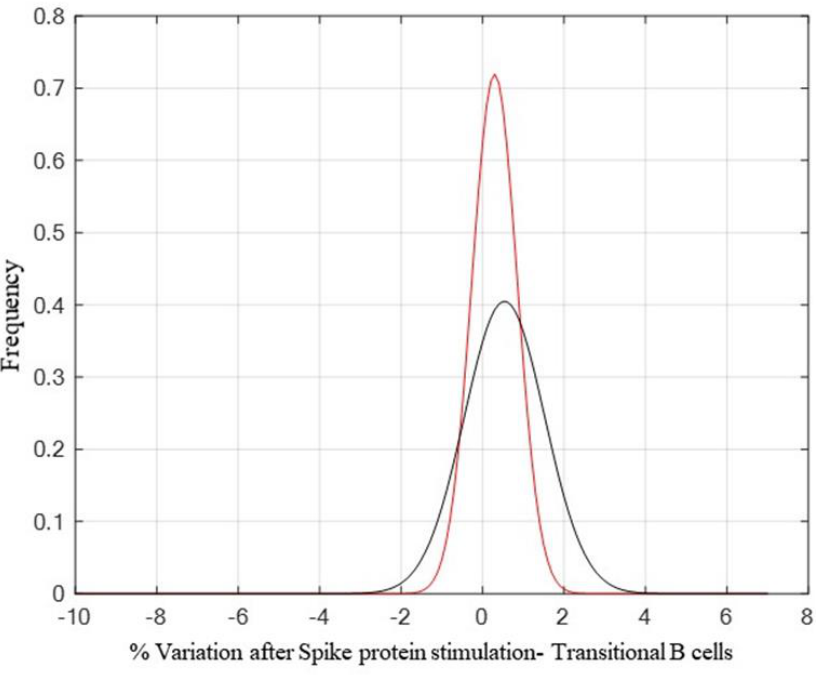
Figure 6. A comparison between the control probability density function (pdf) ( p = 0.4170 and h0 = 0), shown in red, and the high responder population pdf ( p = 0.7146 and h0 = 0), shown in black, highlights a small increase after antigen stimulation of transitional B-cells. Tests for the verification of pdf adherence have been conducted through the Chi2 square method.